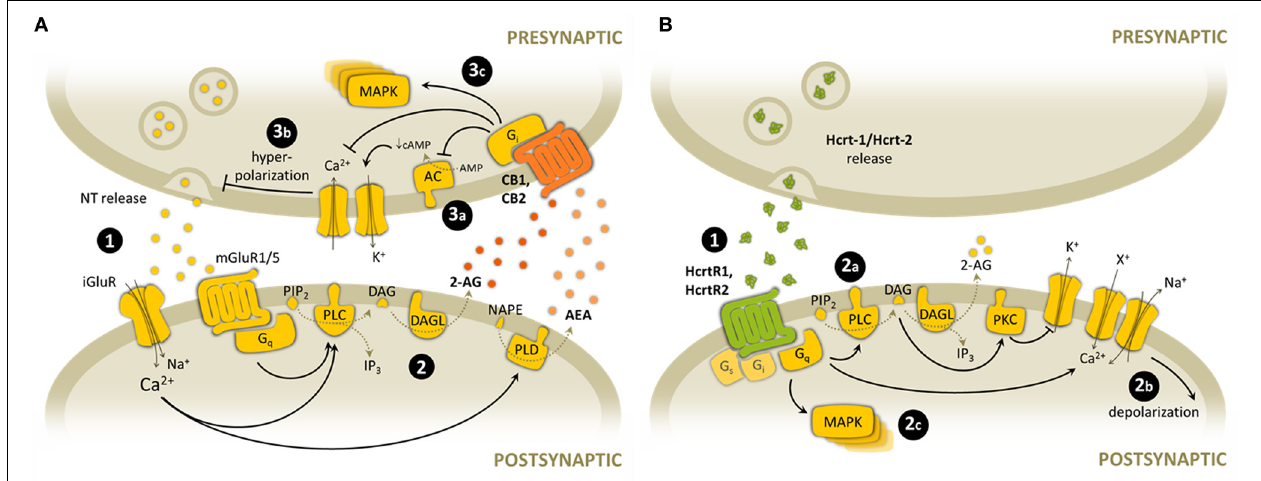
FIGURE 2 | Overview of the main synaptic signaling mechanisms of endocannabinoid and hypocretinergic systems. (A) Endocannabinoid-mediated synaptic signaling. (1) Glutamate is released from presynaptic terminals and stimulates both ionotropic and metabotropic glutamate receptors, leading to postsynaptic depolarization through Ca 2 + entrance and Gq-protein activation. (2) High Ca 2 + concentration stimulates endocannabinoid synthesis through PLC and PLD. 2-AG synthesis is also mediated by Gq-protein activation. (3) Endocannabinoids are released to the synaptic cleft and activate CB1 and CB2 presynaptic receptors. Some of the main downstream consequences of CB receptor activation and subsequent Gi-protein stimulation are: (3a) inhibition of AC activity, (3b) membrane hyperpolarization after modulation of K+ and Ca2+ channels, and subsequent inhibition of NT release, (3c) activation of protein kinase cascades such as MAPK pathway. (B) Hypocretin-mediated synaptic signaling. (1) Hypocretins are released from presynaptic terminals and